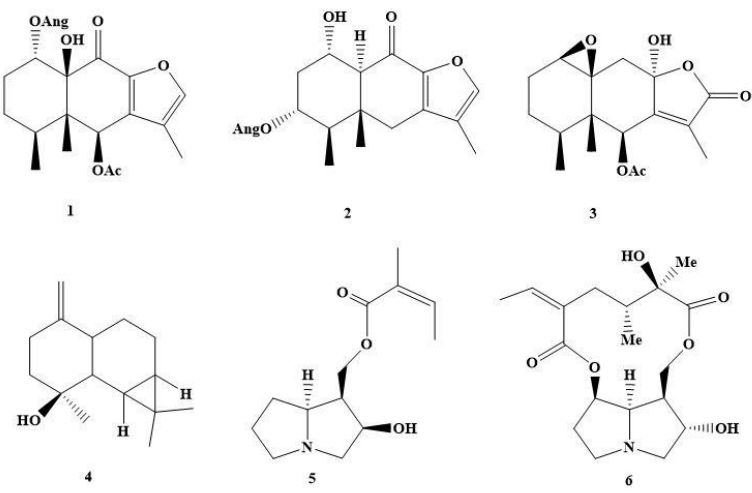
Figure 1. Chemical structures of compounds 1 – 6 .